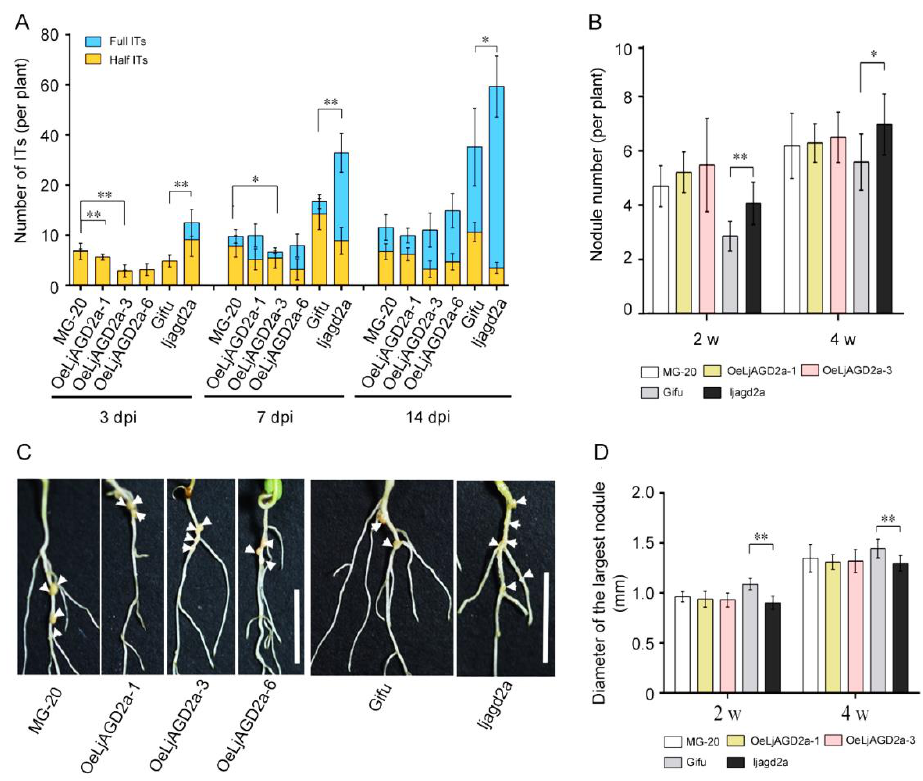
Figure 7. Changes in LjAGD2a expression affect L japonicus nodulation. ( A ) Numbers of infection threads (ITs) in transgenic plants and insertion mutants. Consistently higher numbers of ITs, relative to numbers in wildtype plants, were found in ljagd2a plants after M. loti inoculation. We also found fewer ITs in OeLjAGD2a plants at 3 days post-infection (dpi), but not 7 or 14 dpi. ( B ) Nodule numbers were higher in ljagd2a plants, but unchanged in OeLjAGD2a lines, relative to numbers in wildtype plants. ( C ) Nodules on roots 2 weeks after inoculation of plants. White arrows indicate nodules on the roots. ( D ) Measurements of the largest nodules on plants 4 weeks after inoculation with M. loti showing that mutation of LjAGD2a reduced nodule size. 15 – 20 plants were used in each replicate and three replicates per genotype were used in experiments providing data presented in A, B and D (±SD). * and ** indicate p < 0.5 and p < 0.01, respectively, according to the Duncan test.